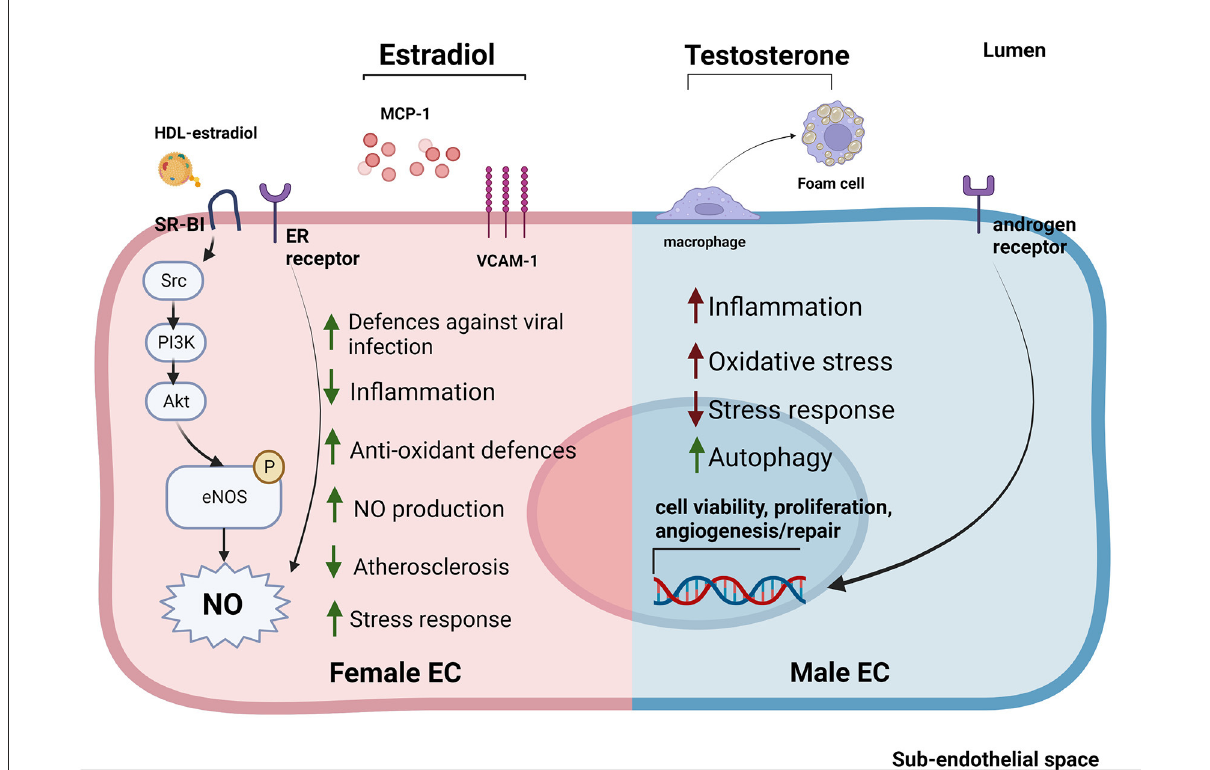
FIGURE2 Sex-specific gene expression patterns and sexual hormones influence EC response to stimuli and EC-HDL cross talk. ECs derived from female donors (left) display reduced sensibility to stress and inflammation thanks to the activation of sex-specific pathways involved in stress response. Estradiol is able to reduce inflammation by reducing MCP-1 release and VCAM-1 expression. Furthermore, estradiol bound to HDLs is able to strongly activate SR-BI pathway increasing the NO production (53, 114, 116, 117). On the contrary, ECs derived from male donors (right) display a stronger susceptibility to inflammation, increased levels of oxidative stress and autophagy (118–120). Testosterone also contributes to create a pro-inflammatory environment by favoring the transformation of macrophages into foam cells (121). Estrogens stimulate NO production in both sexes through the activation of ER receptors (114). In contrast, androgen receptors are able to increase the expression of genes involved in cell viability, proliferation and angiogenesis/repair both in men and women ECs